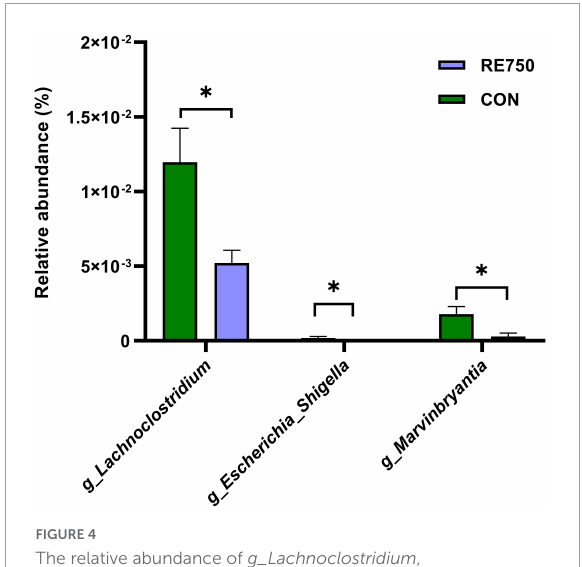
FIGURE4 The relative abundance of g_Lachnoclostridium , g_Escherichia_Shigella , and g_Marvinbryantia in control group and RE750. Data were subjected to t -test analysis, and results are shown as mean ± SEM ( n = 7). Significant correlation was marked by ∗ P ≤